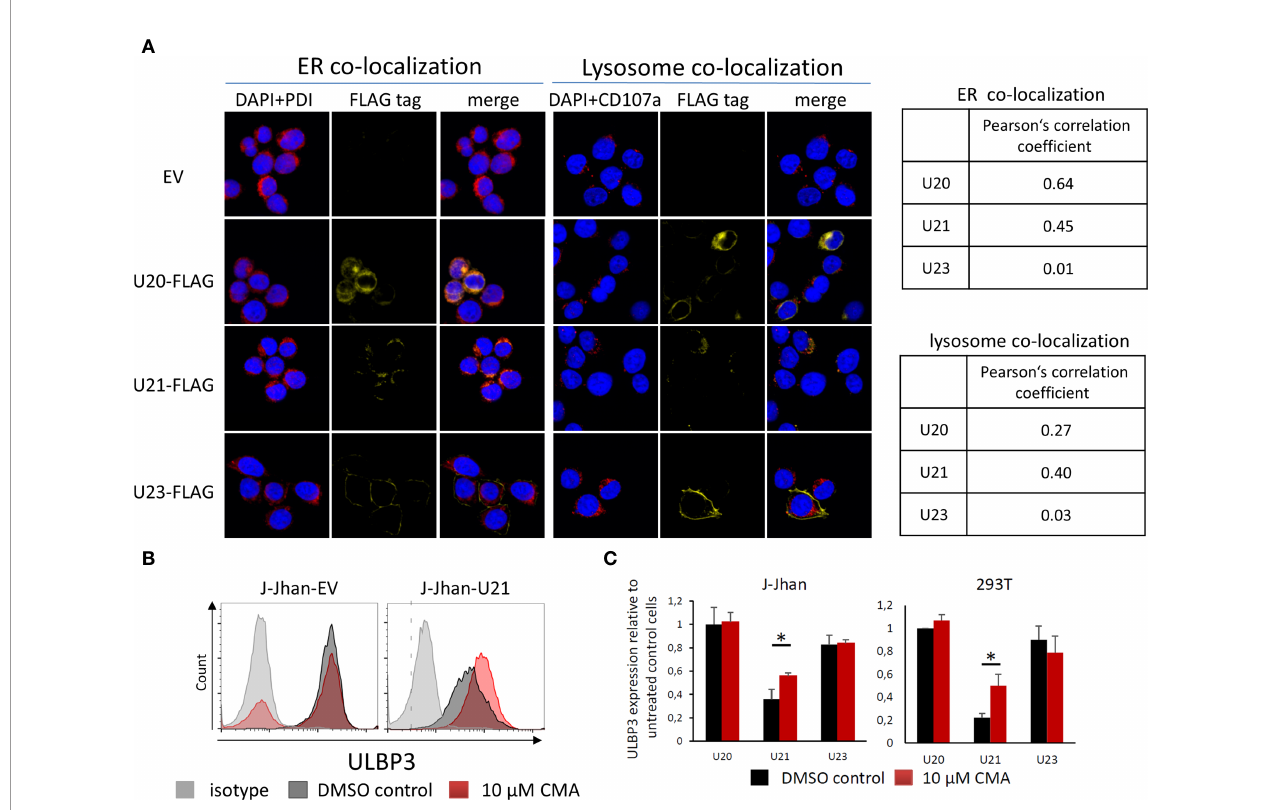
FIGURE 3 | Viral U20 and U21 proteins localize to the secretory pathway. (A) Localization of U20, U21 and U23 in 293T cells determined by FLAG tag staining (yellow). PDI was co-stained to assess the localization to the endoplasmic reticulum (red, left); CD107a served as a marker for late endosomes (red, right). Nuclei were counterstained with DAPI (blue). Pearson ’ s correlation coef fi cients describe overlap of FLAG staining and organelle marker staining. (B) Flow cytometric analysis of ULBP3 on J-Jhan and 293T transfected with U21 or controls treated for 6 hours with Concanamycin A that inhibits lysosomal degradation of proteins. A representative plot is presented for ULBP3 expression on J-Jhan transfectants. (C) Bar histograms show quanti fi cation of one of two independent experiments, *p < 0.05 in student ’ s t test for U21-transfectants in J-Jhan and 293T cells. Differences in all other transfectants are non-signi fi